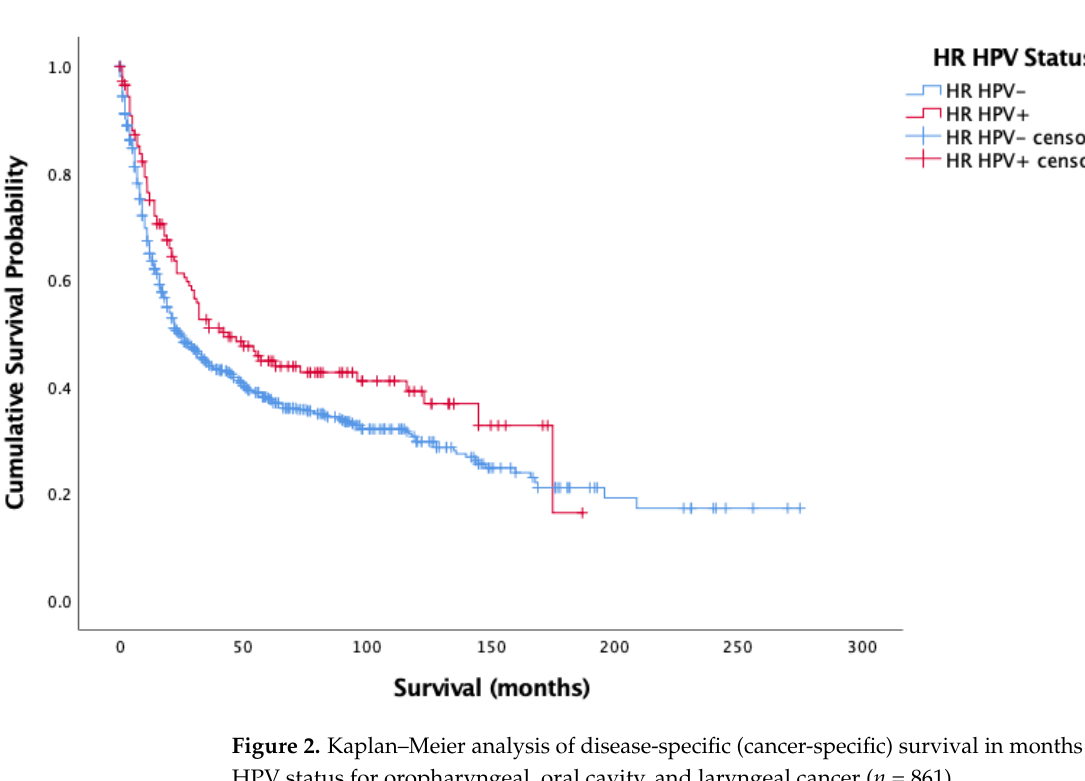
Figure 2. Kaplan–Meier analysis of disease-specific (cancer-specific) survival in months based on HR HPV status for oropharyngeal, oral cavity, and laryngeal cancer (n = 861).